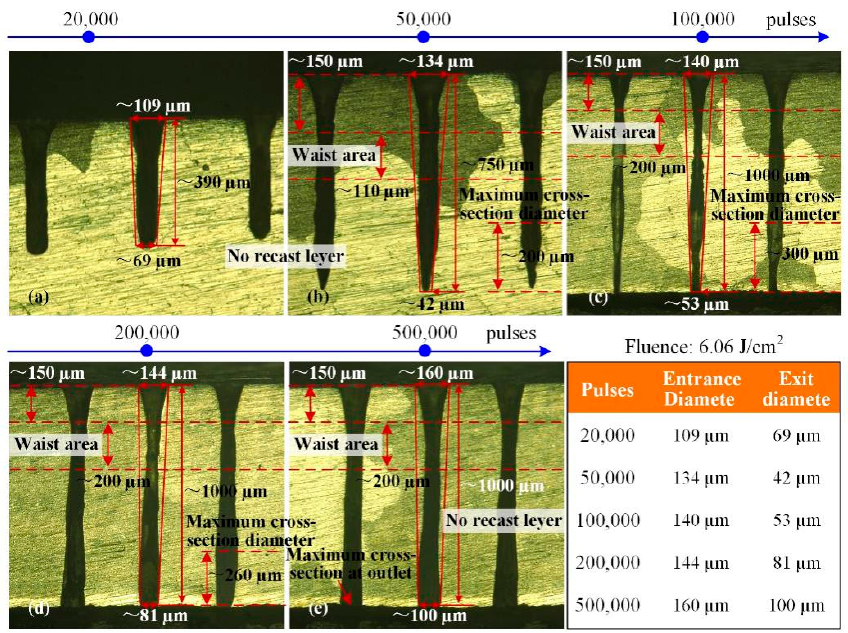
Figure 11. Metallographic images of holes side-walls in Ni-based superalloy. ( a ): 20,000 pulses ( b ): 50,000 pulses ( c ): 100,000 pulses ( d ): 200,000 pulses ( e ): 500,000 pulses.